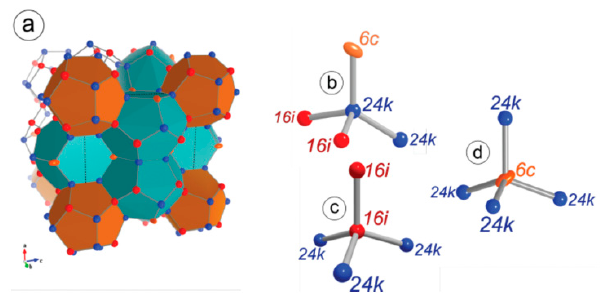
Figure 1. ( a ) Crystal structure of type I clathrate framework. Local geometry and connectivity of framework sites ( b ) 6 c ; ( c ) 16 i ; ( d ) 24 k . (Reprinted with permission from Roudebush, J.H.; de la Cruz, C.; Chakoumakos, B.C.; Kauzlarich, S.M. Neutron Diffraction Study of the Type I Clathrate Ba 8 Al x Si 46-x : Site Occupancies, Cage Volumes, and the Interaction between the Guest and the Host Framework.